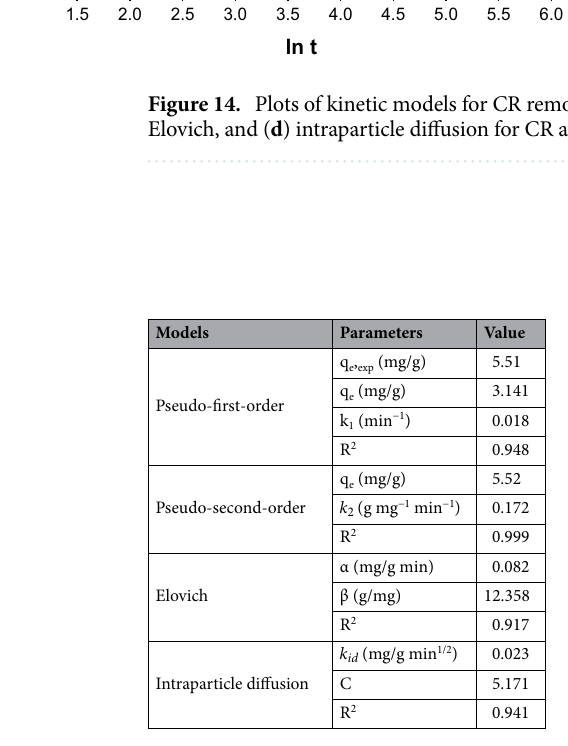
Table 3. Kinetic parameters of CR adsorption onto GSC WCO